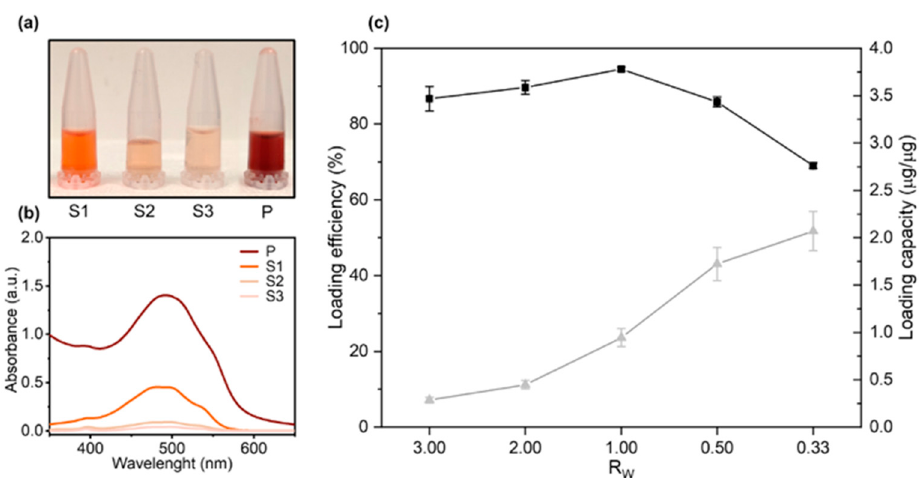
Figure 1. Loading e ffi ciency and loading capacity of doxorubicin (DOX) on graphene oxide (GO) sheets as a function of the GO / DOX weight ratio R W . ( a ) GO-DOX complexes were centrifuged, and the pellet was washed three times with ultrapure water (indicated as S1, S2 and S3 respectively). ( b ) Absorbance spectra measured from the supernatants. After the third washing step, the pellet was resuspended in ultrapure water and the solution (P) used for ( c ) quantification of DOX loading e ffi ciency (black squares) and capacity (grey triangles).